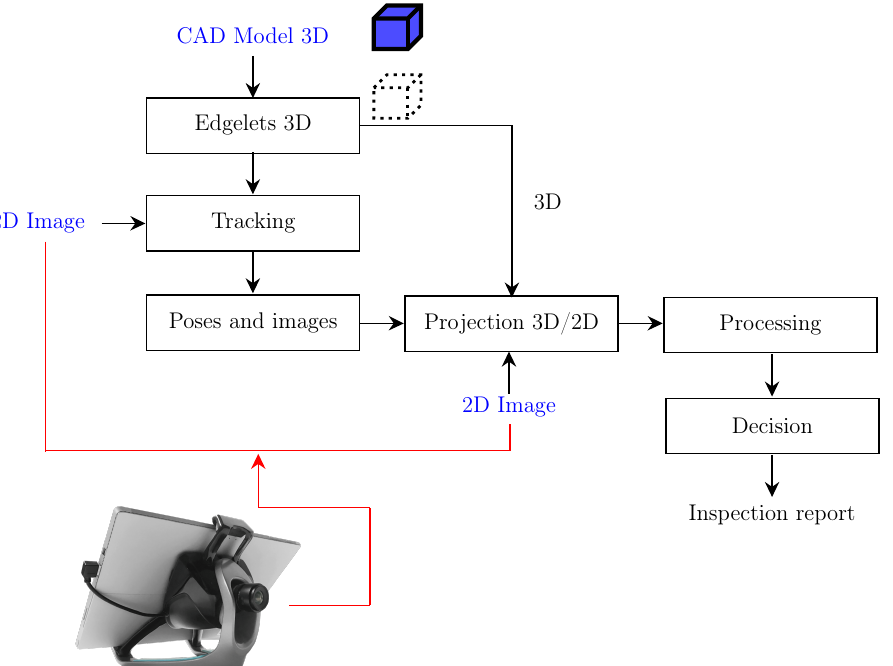
Figure 7. Overview of the detection phase during online processing using tablet-based